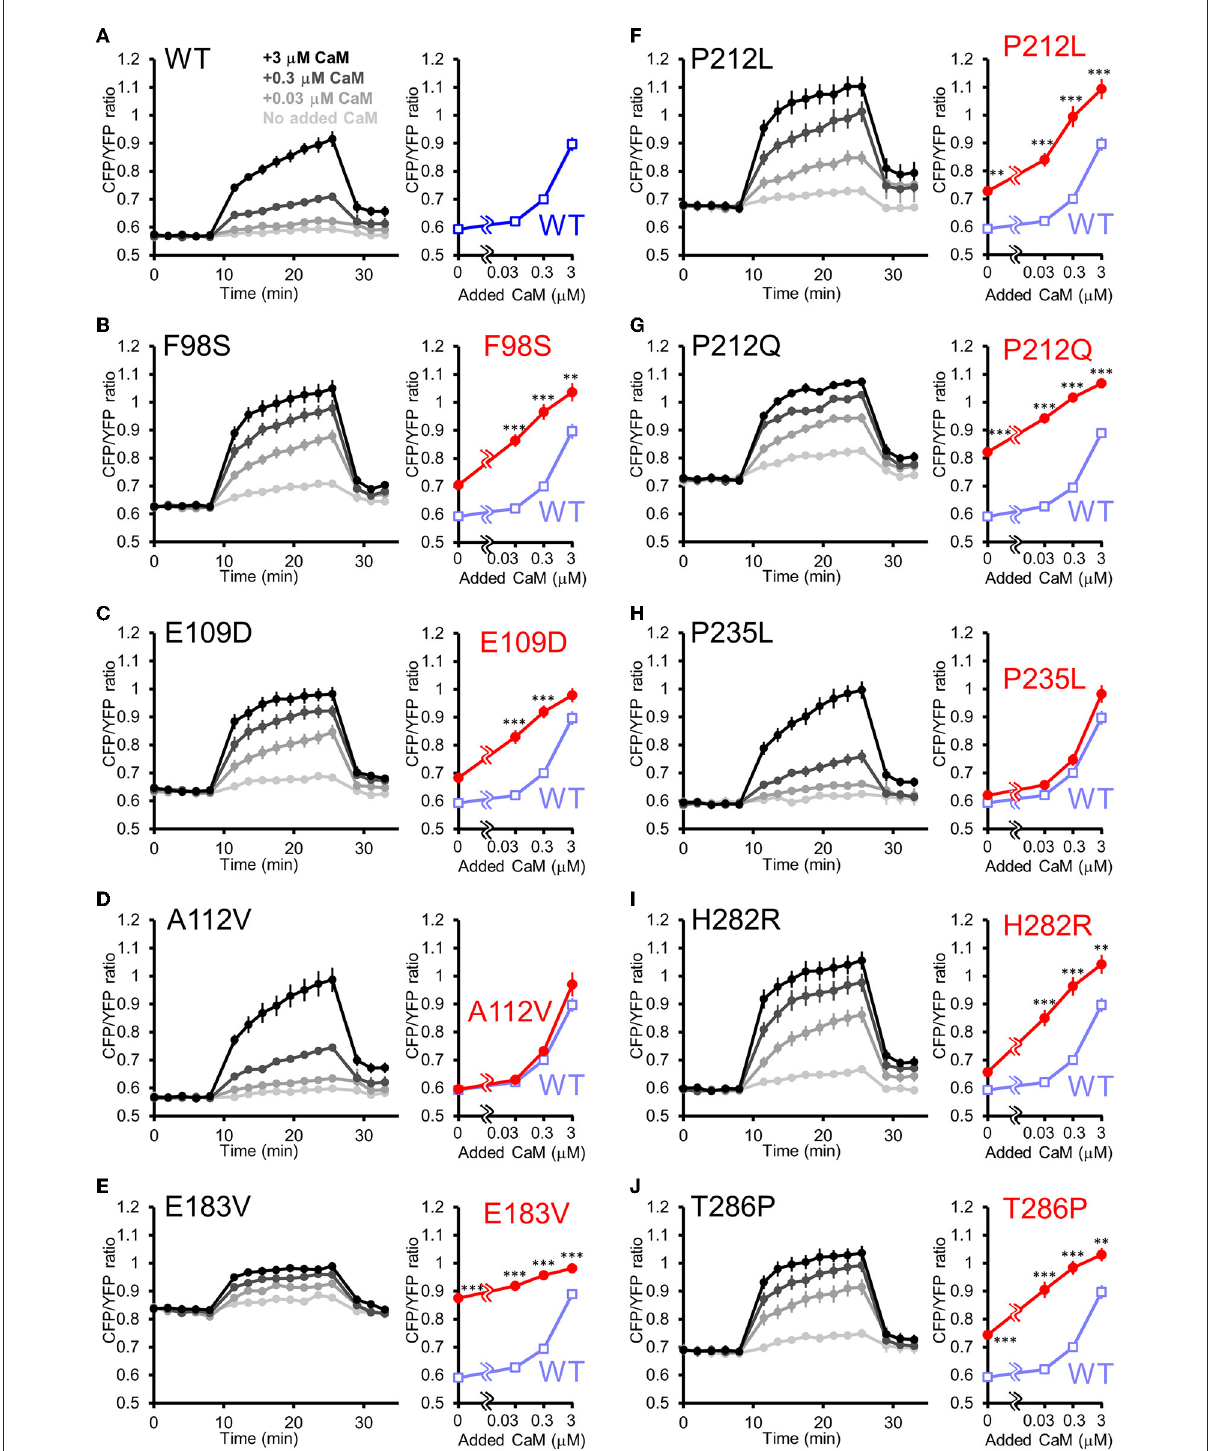
FIGURE5 FRET plate reader analysis of effects of de novo mutations identified from ID on Ca 2 + /CaM-dependent activation of CaMKII α . (A–J) Plate reader FRET assay (left) and CaM dose response curves (right) for hK2 α WT and de novo mutants stimulated by 0, 0.03, 0.3, 3 µ M added CaM. To ease comparison, dose-response curves of WT (shaded blue open square) are overlayed that of each mutant [red filled circle, (B–J) ]. Mean ± s.e.m. are indicated, two-way ANOVA followed by post-hoc Turkey’s test ** p < 0.01, *** p < 0.001. n = 9 for WT, F98S, E109D, A112V, P212L, P235L, H282R and T286P and n = 14 for WT, E183V and